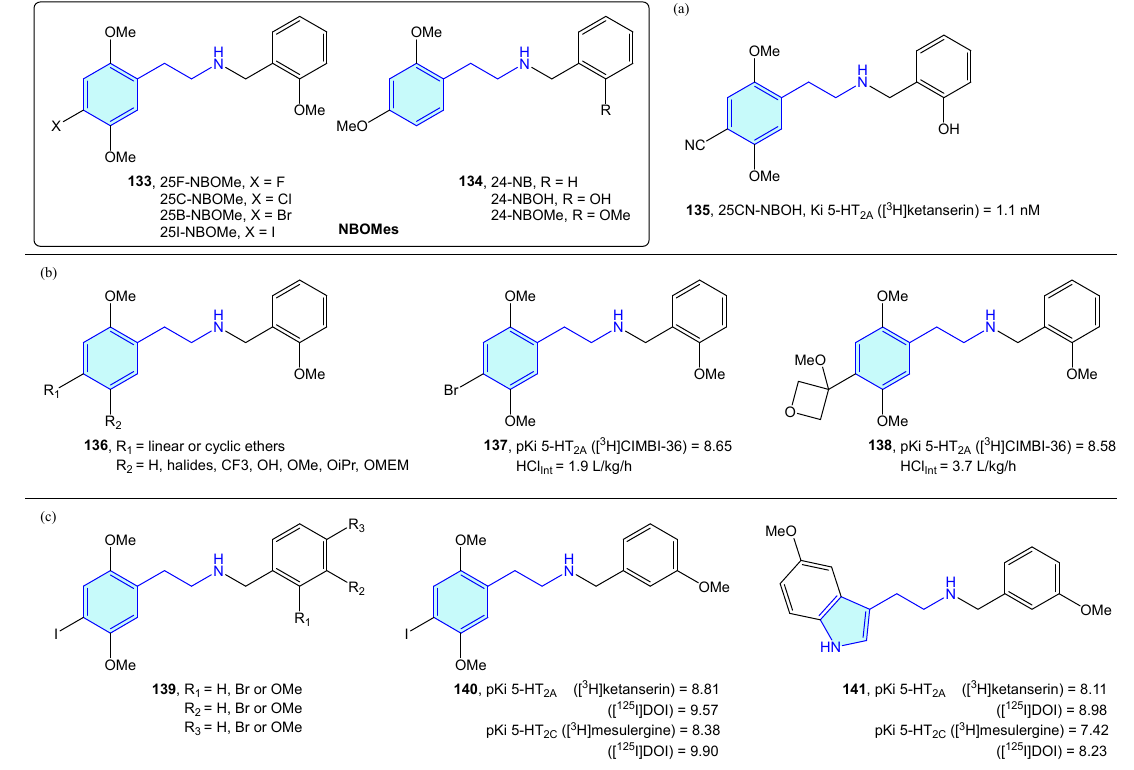
Figure 17 . NBOMes with 5-HT receptor activity. Figure 17. NBOMes with 5‑HT receptor